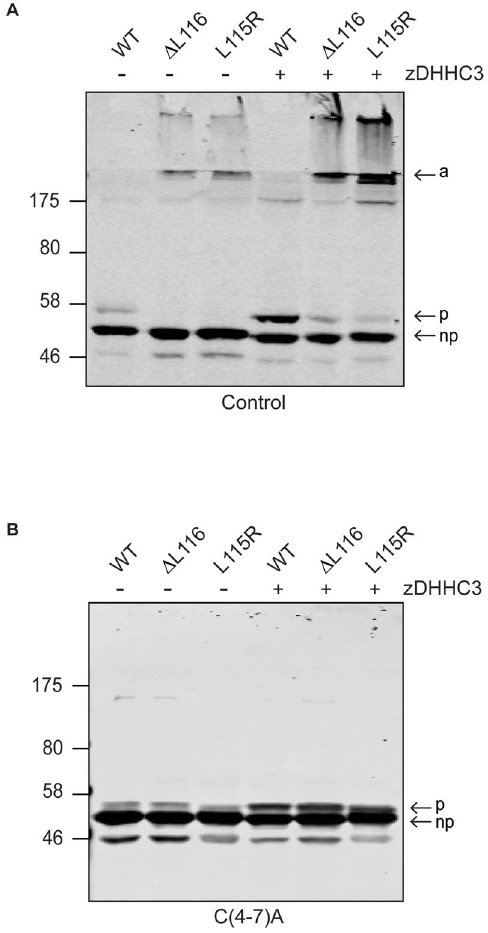
Figure 5. Effect of palmitoylation on aggregation of ANCL mutants. HEK293T cells were transfected for 24 hours with wild-type, L115R or Δ L116 EGFP-CSP α constructs, without ( A ) or with ( B ) the C(4-7) A substitutions, and with or without HA-zDHHC3 as indicated. Cells were then lysed and examined by immnoblotting with anti-GFP. The position of the molecular weight marker is shown on the left , and the arrows indicate the aggregated ( a ), palmitoylated monomeric ( p ) and non-palmitoylated monomeric ( np ) forms of the